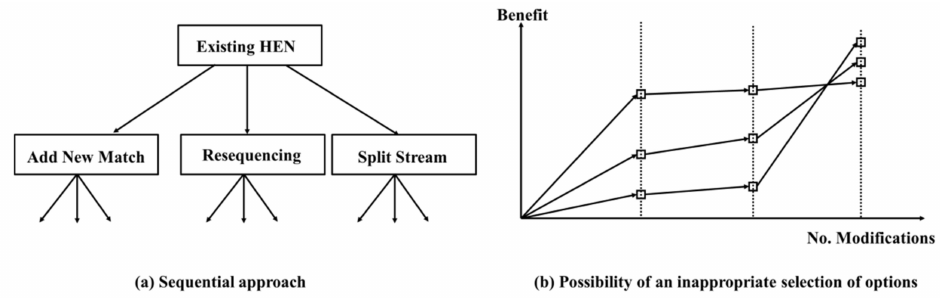
Figure 5. Paths for multiple